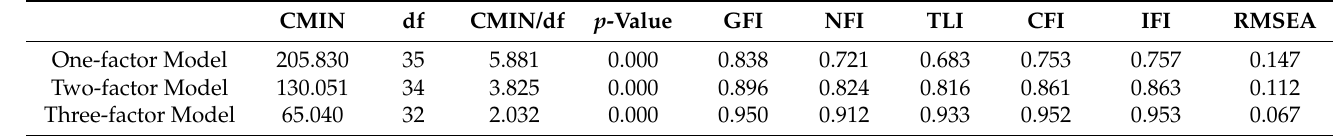
Table 8. Model comparisons for dimensionality (Sample 2, n =